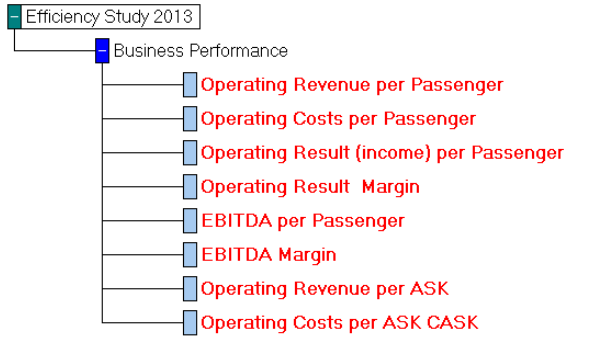
Figure 11: Decision Tree of Business Performance